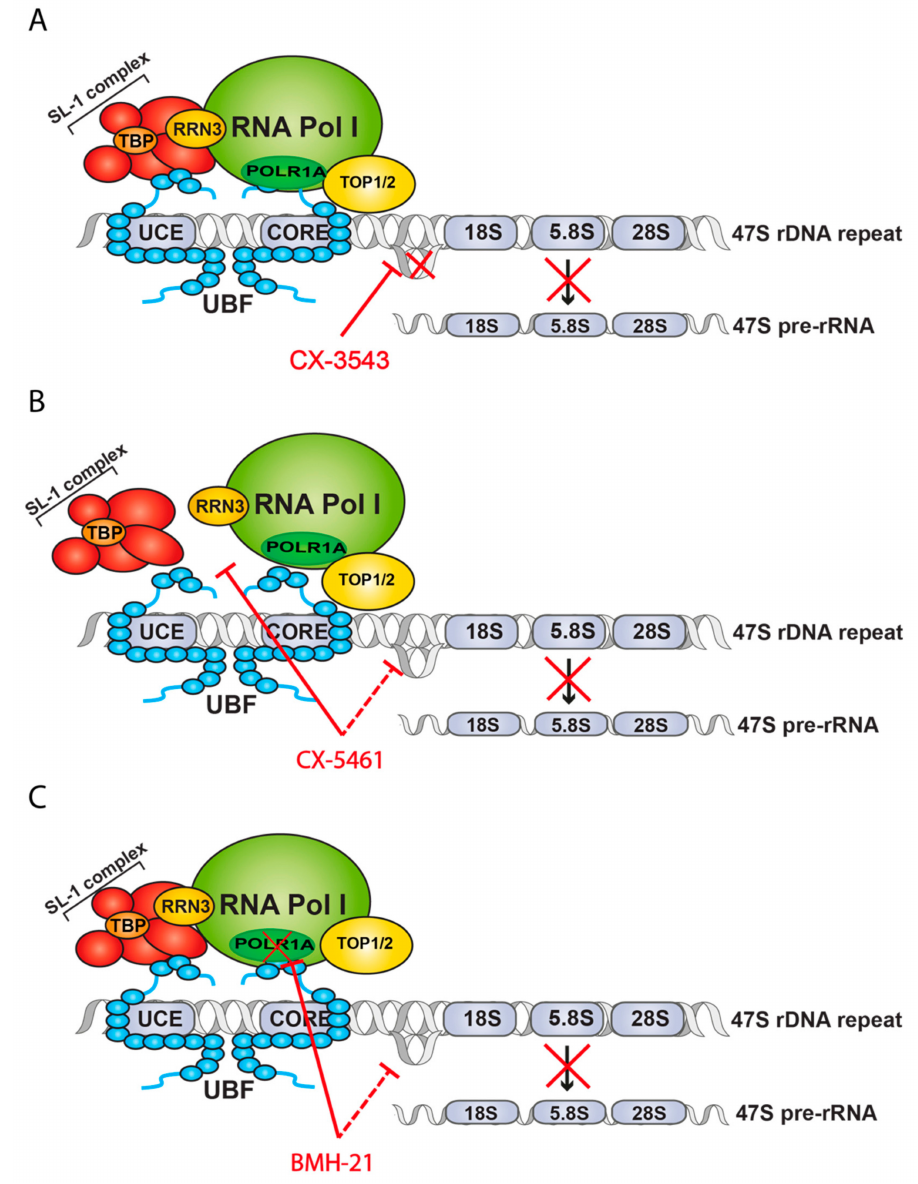
Figure 4. Schematic representation of mechanisms of action of specific Pol I transcription inhibitors. ( A ) Mode of action of CX-3543, disruption of Nucleolin binding to G4 DNA structures. ( B ) Mode of action of CX-5461, disruption of Pol I-SL-1 interaction and an unclear role in G4 stabilization. ( C ) Mode of action of BMH-21, disruption of Pol I complex and ubiquitin-mediated proteasome degradation of POLR1A (RPS194), inhibition of transcription elongation and an unclear role in G4 stabilization. CX-3543 has successful completed Phase I dose finding clinical trial [78] and reached Phase II clinical trial for Neuroendocrine and Carcinoid tumours (NCT00780663) but was withdrawn due to bioavailability issues